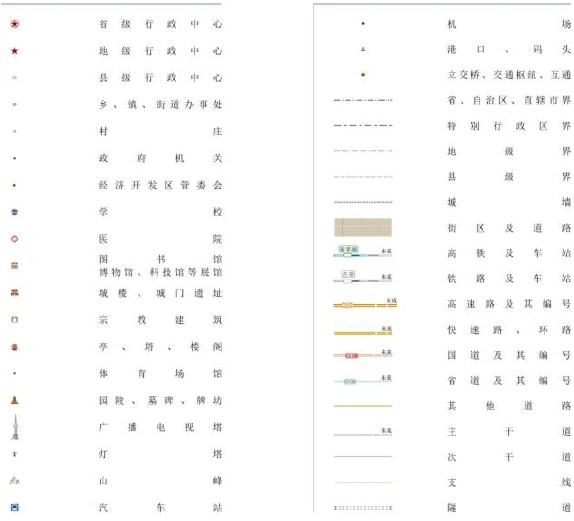
Figure 4. symbol library system of city